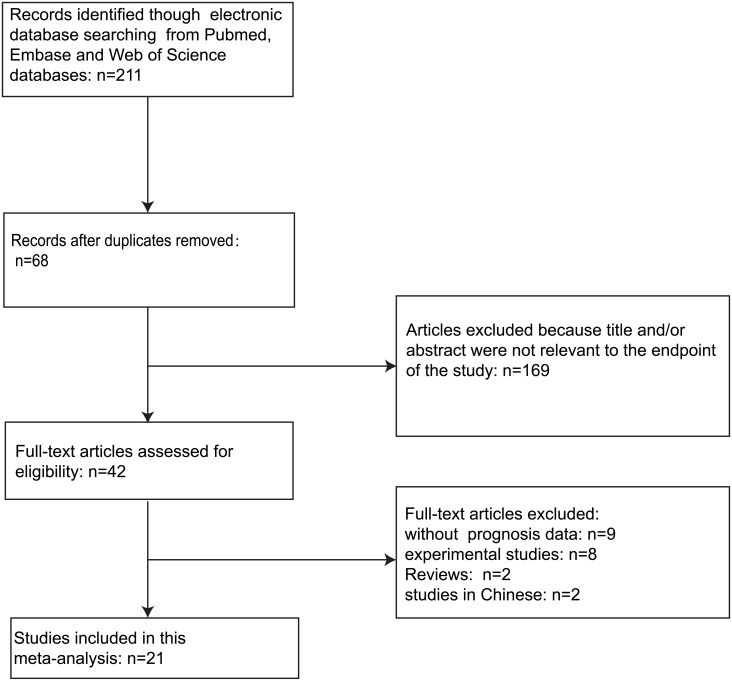
The flow chart of the selection process in our meta-analysis.